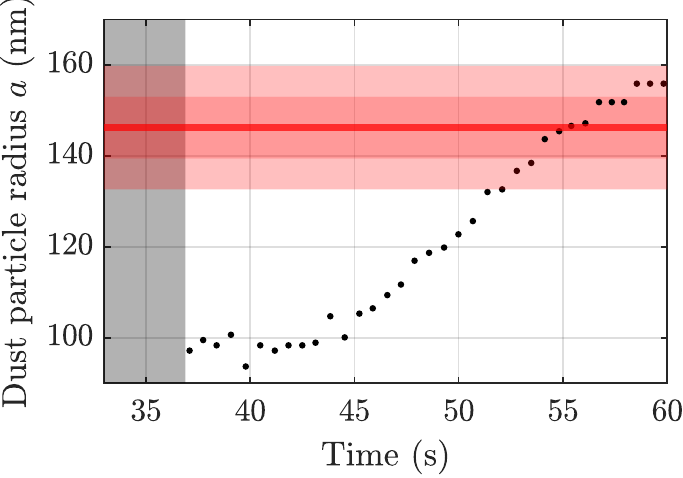
Figure A2. Result of the dust particle size for an experiment in which particles have been collected on an SEM substrate. The gray-shaded area indicates the time period after discharge ignition during which the transmittance remains similar to a pristine plasma, which inhibits proper determination of the dust particle size and density. The red line indicates the mean of the dust particle size inferred by the SEM image in Figure A1, while the dark and light red regions indicate the 1 σ and 2 σ regions, respectively. The raw data used for the fitting procedure and the production of this figure has been published in Tim Jacobus Adrianus Staps et al. [31] 2022 J. Phys. D: Appl. Phys. 55 08LT01 (https://doi.org/10.1088/1361-6463/ac3581), licensed under a Creative Commons Attribution (CC BY) license and used with the permission of the